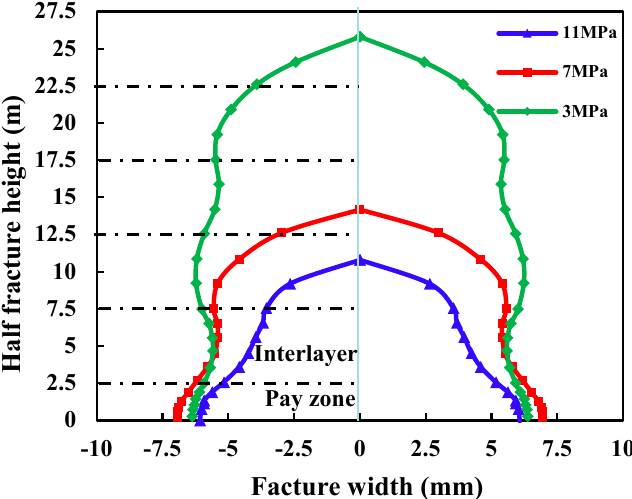
Figure 3. HF morphology under different interlayer stress contrast. As far as HF width is concerned, owing to the alternating occurrence of the pay zone and the interlayer (the dashed line represents the interface between the pay zone and the interlayer), the horizontal minimum principal stress contrast between the zones constantly changes the HF width and the longitudinal distribution of HF width is wavy (Figure 3). larger the central HF width. In addition, the HF width in the pay zone where the HF center is located is less affected by the interlayer stress. The width of the HF center corresponding 12.1 mm,